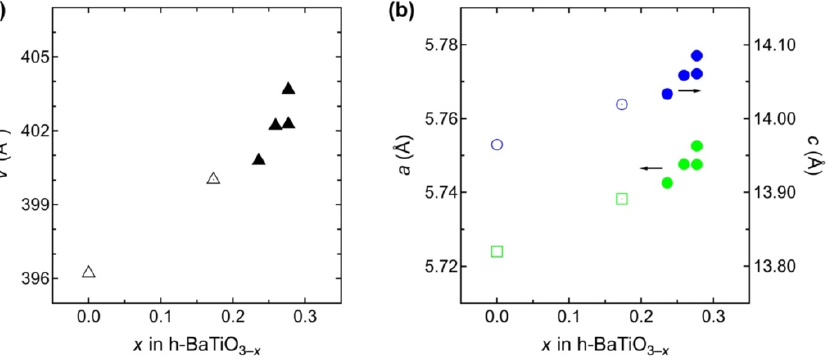
Figure 4. Lattice parameters of ( a ) V , ( b ) a , and c as a function of x taken from 6H-BaTiO 3 (after Akimoto [28]), 6H-BaTiO 2.83 (after Sinclair [30]), and 6H-BaTiO 3 − x in this work (see Table S3-5). The errors are within the size of the symbols.